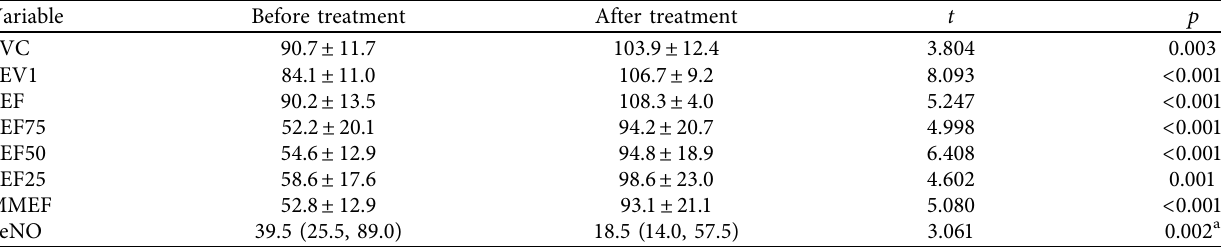
Table 6: Comparison of pulmonary function and FeNO in the single allergic group before and after treatment.